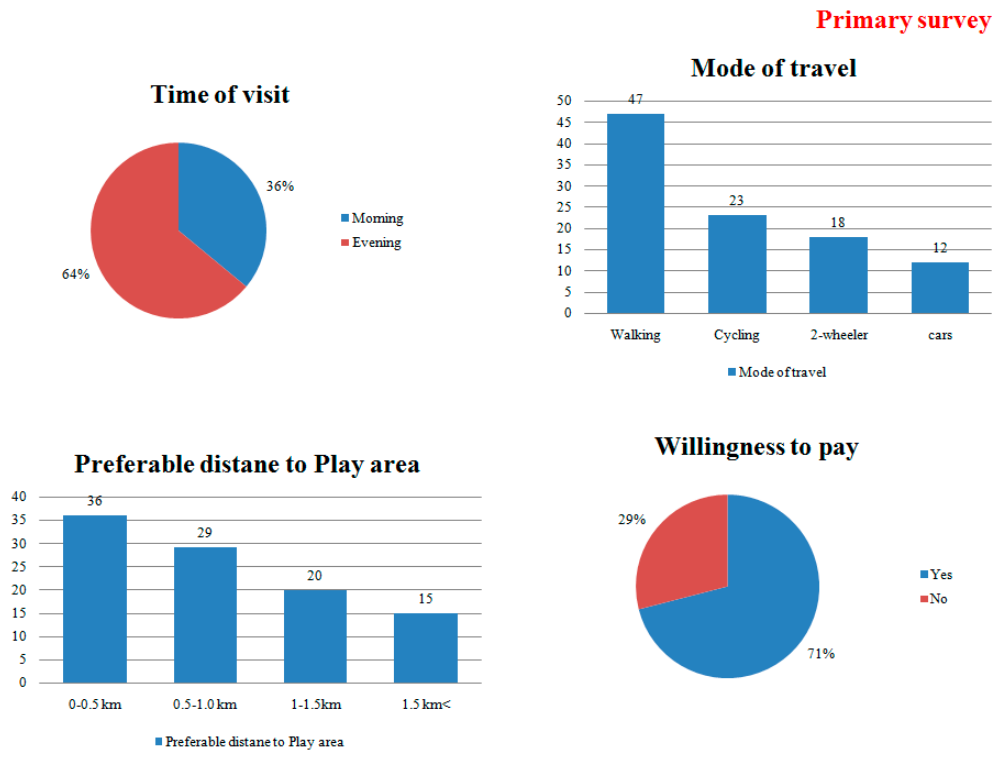
Figure 5. Children’s preferences for play provisions and parks in neighborhoods.